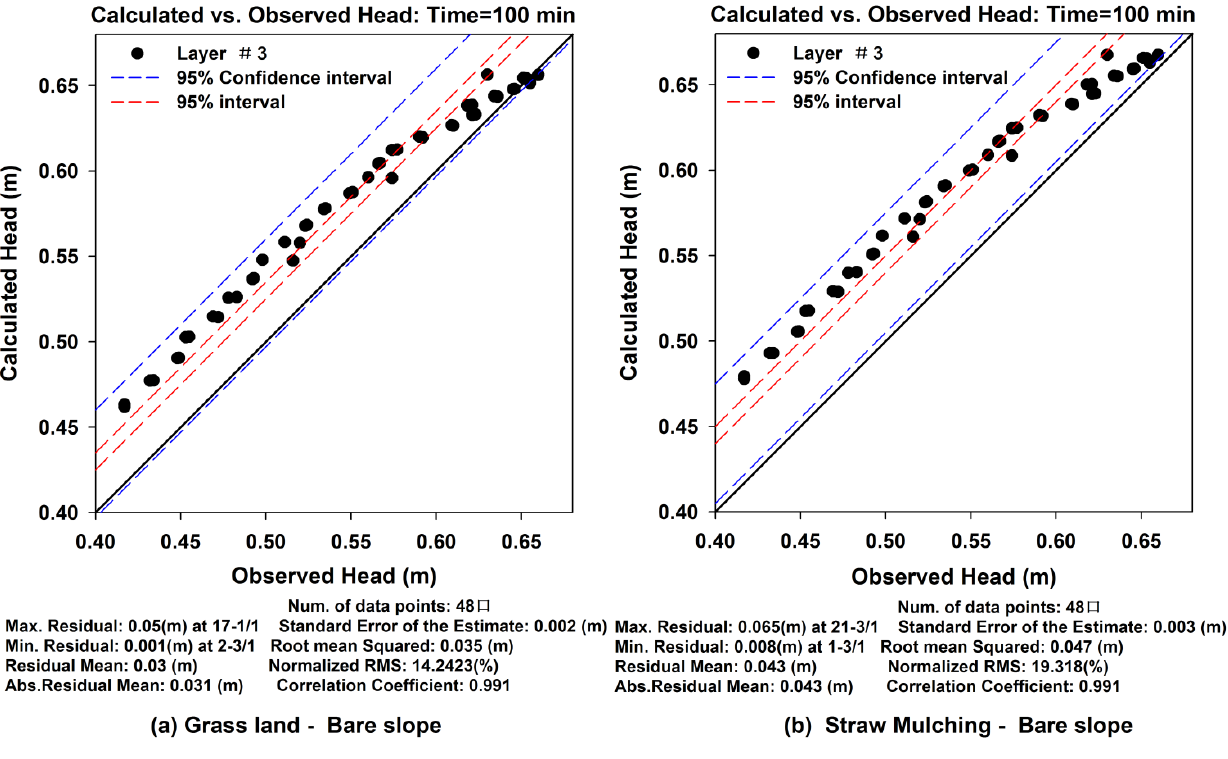
Figure 21. The scatter graph of the calculated vs. observed values when the underlying surface converted from straw mulching and grassland to bare slope. ( a ) shows the compared results when the underlying surface converted from straw mulching to bare slope; ( b ) shows the compared results when the underlying surface converted from grassland to bare slope. The groundwater heads are shown as dots and the solid lines mean the calculation heads are equal to the observed